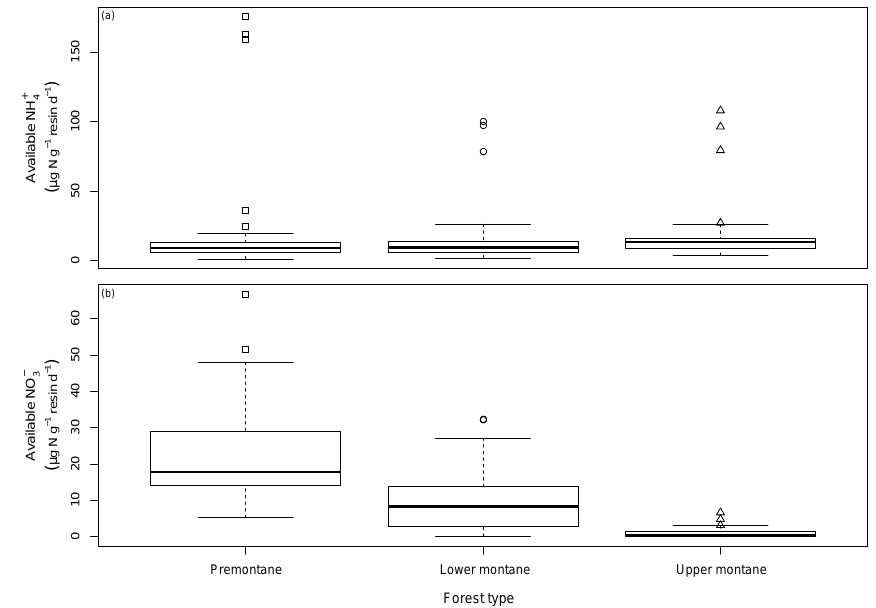
Figure 3. Boxplots of monthly plot means of inorganic nitrogen availability by forest type (a) available NH +